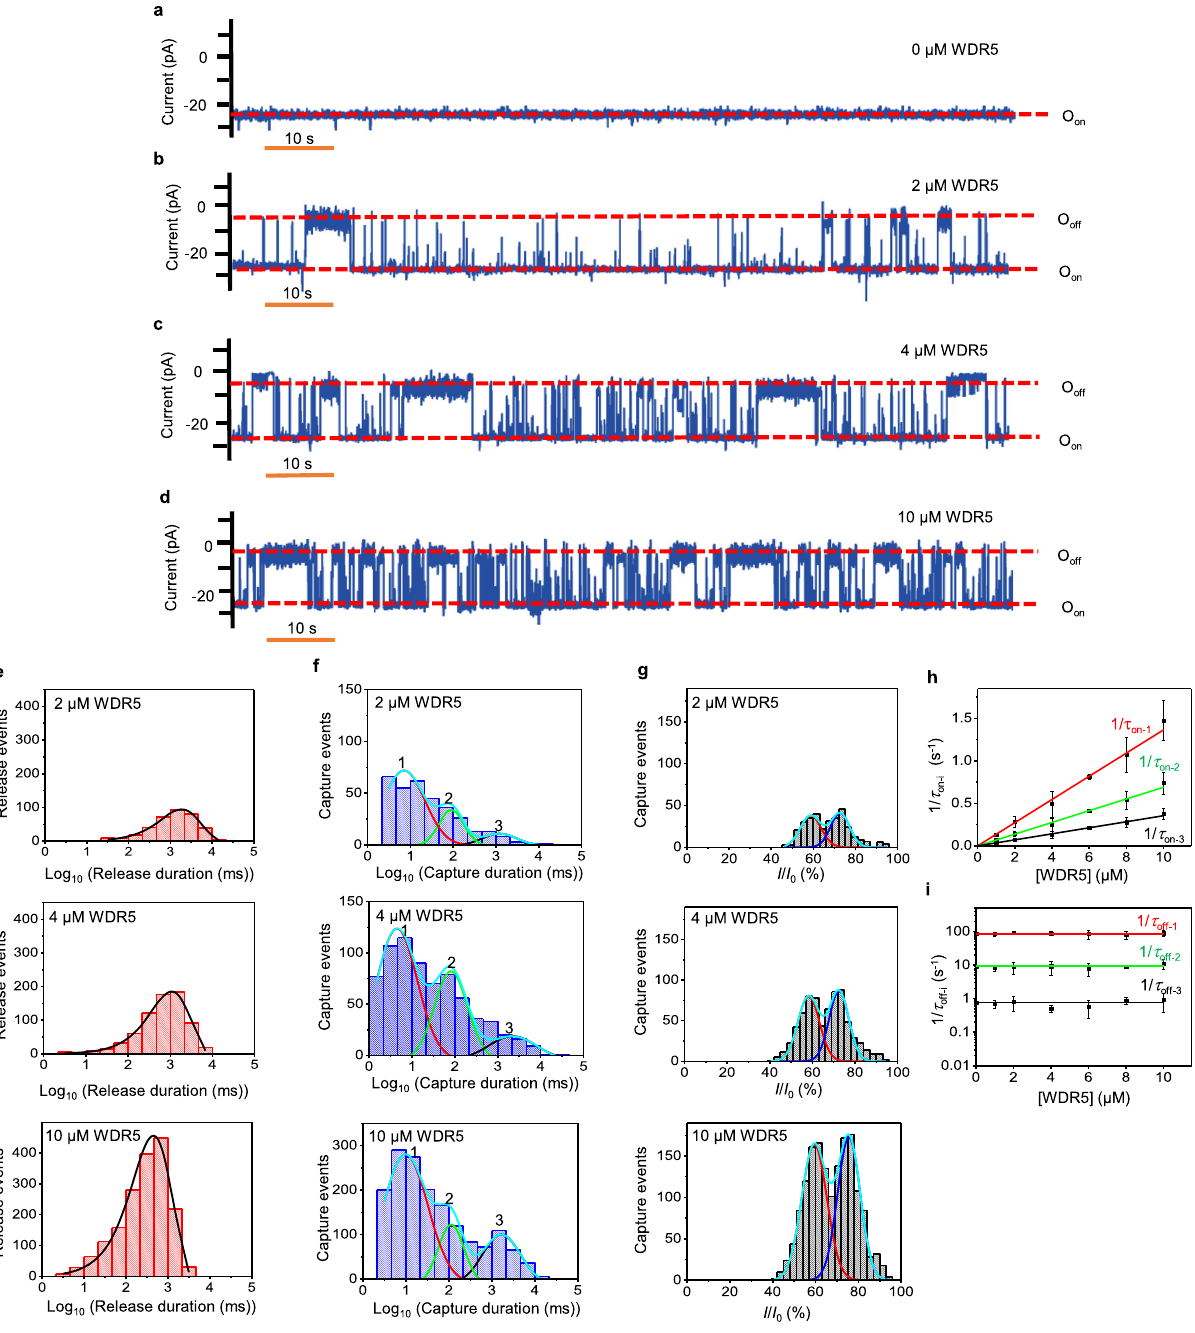
Fig. 2 Real-time detection of WDR5. a MLL4 Win tFhuA. b MLL4 Win tFhuA exposed to 2 μ M WDR5. c MLL4 Win tFhuA exposed to 4 μ M WDR5. d MLL4 Win tFhuA exposed to 10 μ M WDR5. O on and O off are release and capture substates, respectively. Data was replicated in three independent experiments. e Histograms of release durations, whose values (mean ± s.e.m.) were 2.0 ± 0.2 s (number of events: N = 363), 1.2 ± 0.4 s ( N = 717), and 0.41 ± 0.09 s ( N = 1791) at 2, 4, and 10 μ M WDR5, respectively. f Histograms of capture durations. The cumulative fi ts are marked in cyan. The red, green, and black curves indicate fi ts for short-, medium-, and long-lived captures, respectively. For 2 μ M WDR5, they (mean ± s.e.m.) were 0.009 ± 0.001 s, 0.096 ± 0.001 s, and 1.4 ± 0.1 s, respectively (number of events: N = 329). For 4 μ M WDR5, they were 0.008± 0.001 s, 0.12 ± 0.01 s, and 2.0 ± 0.1 s, respectively ( N = 717). For 10 μ M WDR5, they were 0.010 ± 0.001 s, 0.10 ± 0.01 s, and 1.4 ± 0.1 s, respectively ( N = 1624). g Histograms of normalized current blockades. The cumulative fi ts are marked in cyan. The red and blue curves indicate fi ts of smaller and larger blockades, respectively. For 2 μ M WDR5, these values (mean ± s.e.m.) were 59 ± 0.9% and 73 ± 0.8%, respectively (number of events: N = 329). For 4 μ M WDR5, they were 58 ± 0.8% and 73 ± 0.7%, respectively ( N = 717). For 10 μ M WDR5, they were 59 ± 0.6% and 75 ± 0.1%, respectively ( N = 1607). h Dose response of 1 / τ on-i . τ on-1 , τ on-2 , and τ on-3 are the mean durations between short-, medium-, and long-lived captures, respectively. i Dose response of 1 / τ off-i . τ off-1 , τ off-2 , and τ off-3 are the mean durations of short-, medium-, and long-lived captures, respectively. In ( h ) and ( i ), data represent mean ± s.d. obtained from either n = 4 (1 and 2 μ M WDR5) or n = 3 (4, 6, 8, and 10 μ M WDR5) distinct experiments. Source data are provided as a Source Data fi